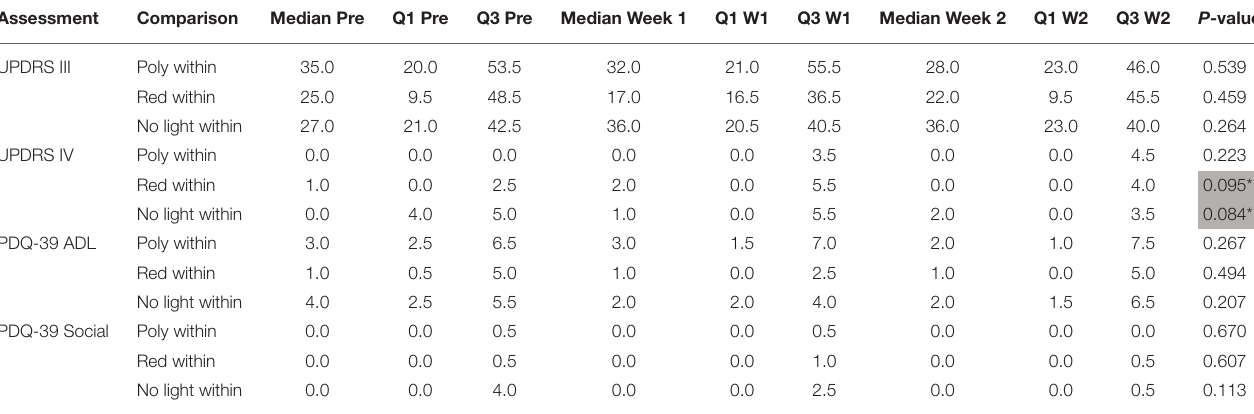
TABLE 2 | The effect of continued daily exposure to polychromatic light, red light or withdrawal of therapeutic light on parameters showing no change in patients that had used the light for at least 4 months prior to commencing the study.